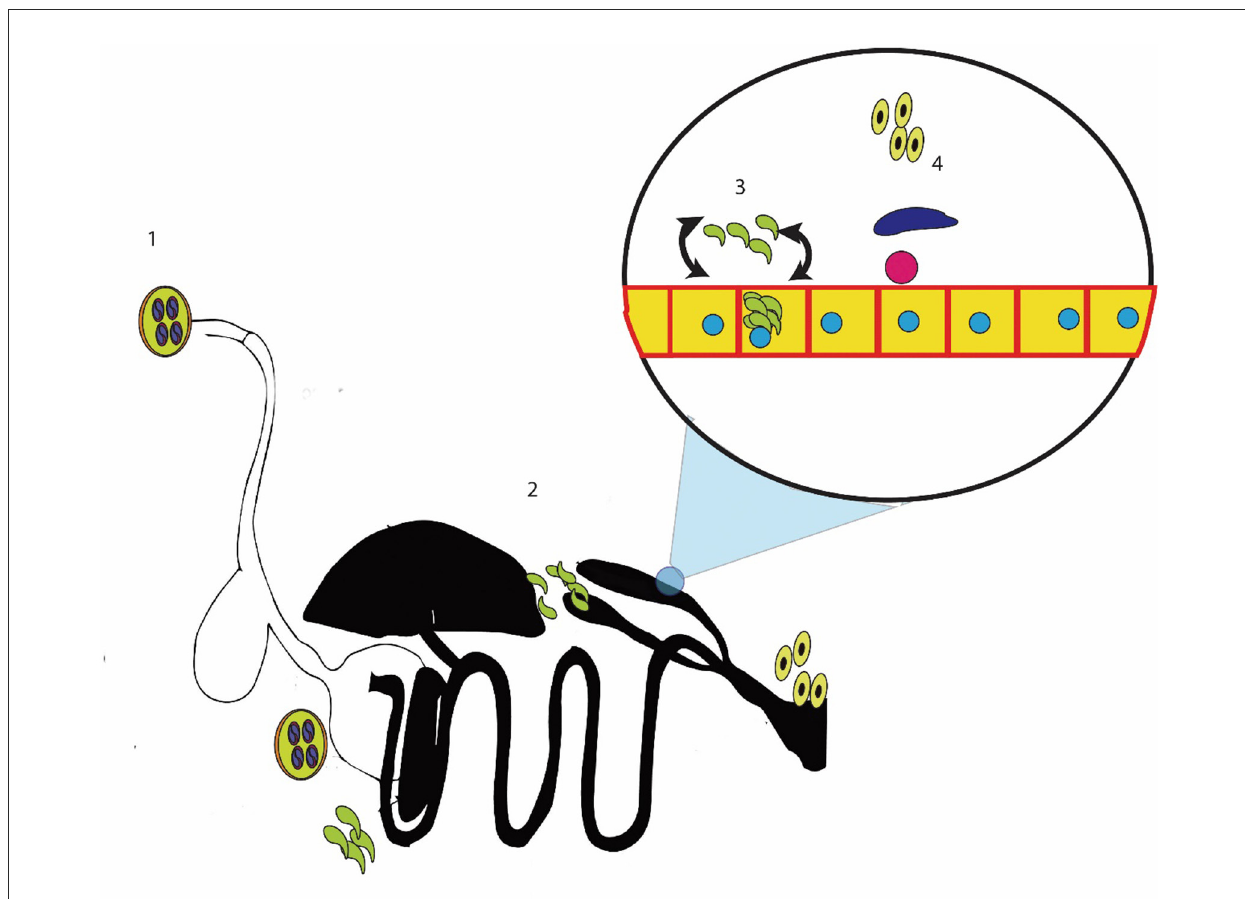
FIGURE1 Methods for controlling cecal coccidiosis; 1: killing the sporocyst or reducing the intake of sporocyst; 2: stopping the entry of sporozoites into the cecal epithelium; 3: killing the sporozoites, merozoites, or schizont-containing cells; and 4: controlling the reproductive stage.